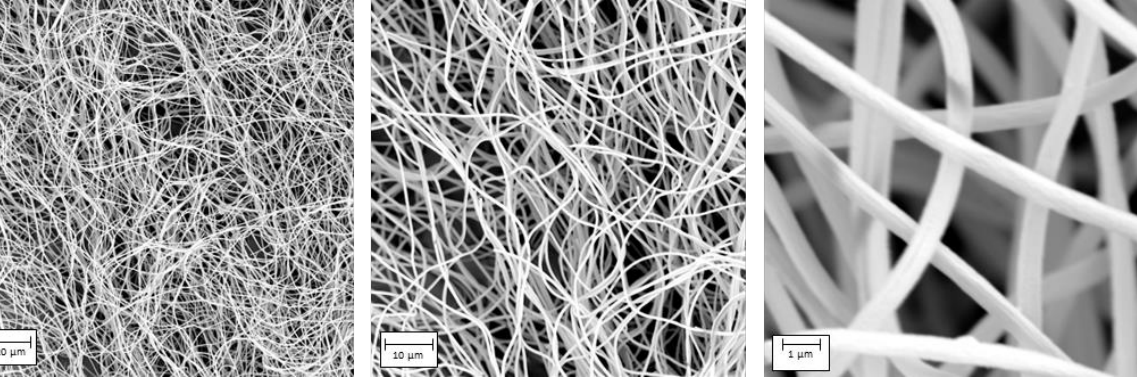
Figure 4. SEM images of PAN-PMMA fibers at magnifications of 1000×, 2500×, and 20,000×, respec- tively.